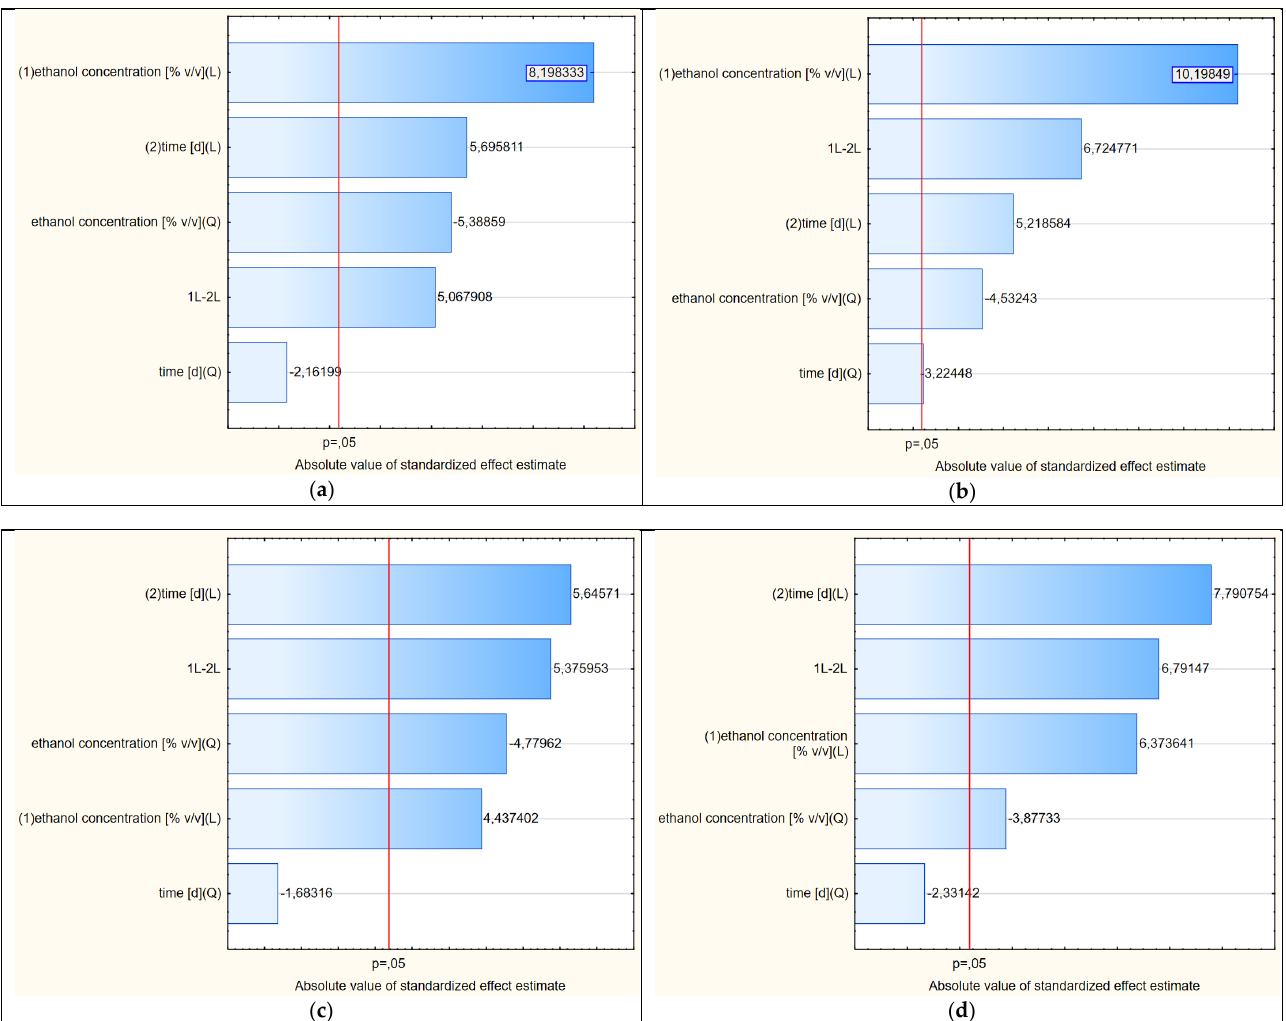
Figure 5. ( a – d ) Pareto charts showing the statistical significance of the factors of variability affecting the shapes of the response surfaces (2D) shown in Figures 4, 6, 8 and 9,